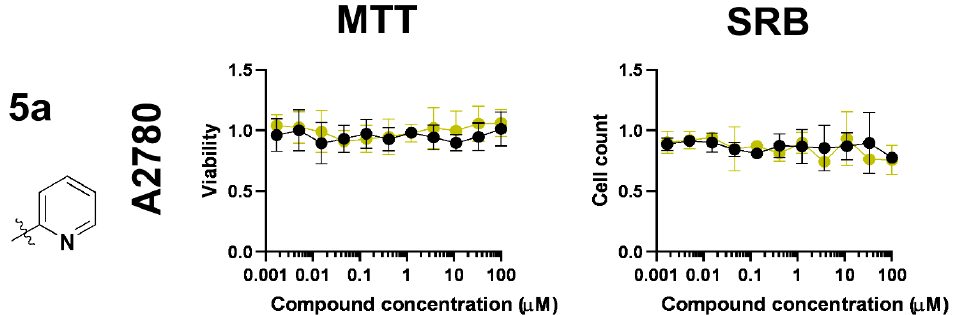
Figure 7. Assessment of the free ligand 5a and its ruthenium complex, Ru-5a , for cytotoxic and cytostatic activity. For MTT and SRB assays, 3 × 10 3 A2780 cells and 1.5 × 10 3 A2780 cells were plated in 96-well plates, respectively. Cells were treated with the compounds in the concentrations indicated for either 4 h for the MTT assay or for 48 h for the SRB assay. Data are represented as average ± SD from three biological replicates; individual assays were performed in duplicate. Values were normalized for vehicle-treated cells; absorbance for vehicle-treated cells equals 1. Statistical significance was assessed using a one-way ANOVA test comparing all values to the lowest concen- tration of a compound. Before the test, normality was assessed using the Shapiro–Wilk test, and the post hoc test was chosen accordingly. For better visibility, the p values and the distributions are presented in an Excel sheet available at https://figshare.com/s/9ec2a005e6b9e5874c07. Nonlinear regression was performed on the datasets indicated in Table 6. Color code: black—free ligand ( 5a ), khaki—ruthenium complex ( Ru-5a ).